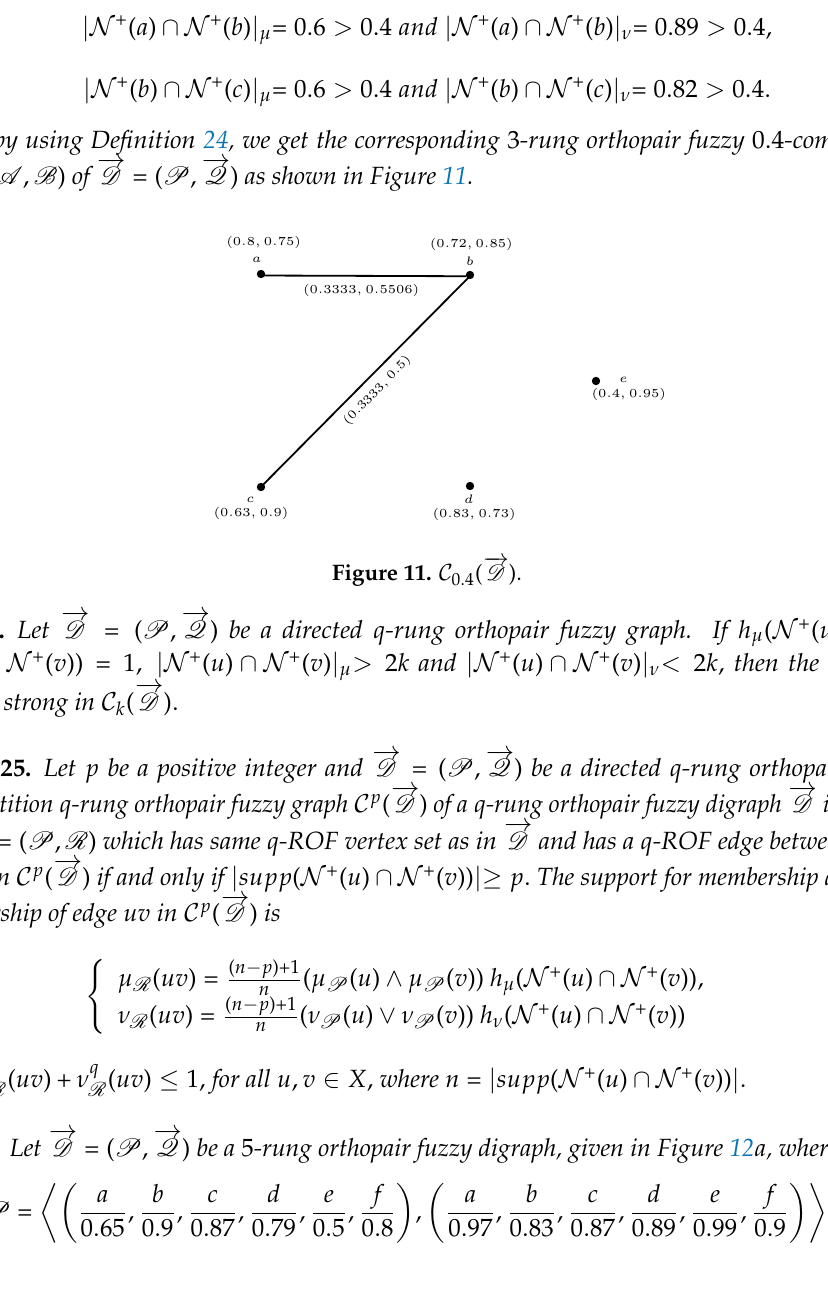
Figure 11. Figure 4.2: